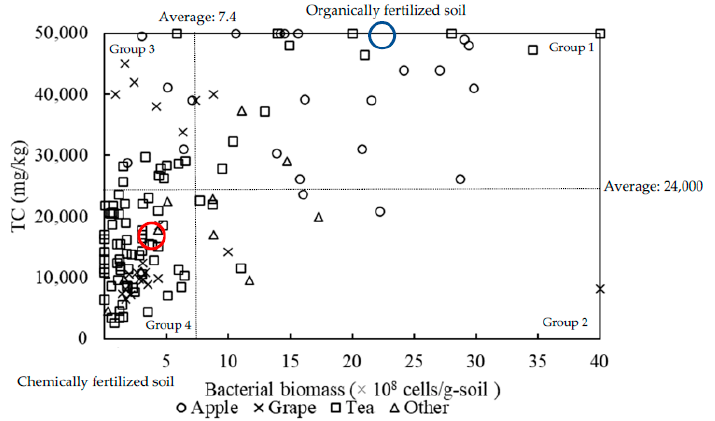
Figure 4. Relationship between total carbon (TC) and bacterial biomass in orchard soils and in the ( ) organic and ( ) conventional farming systems in the current study ( n = 2).